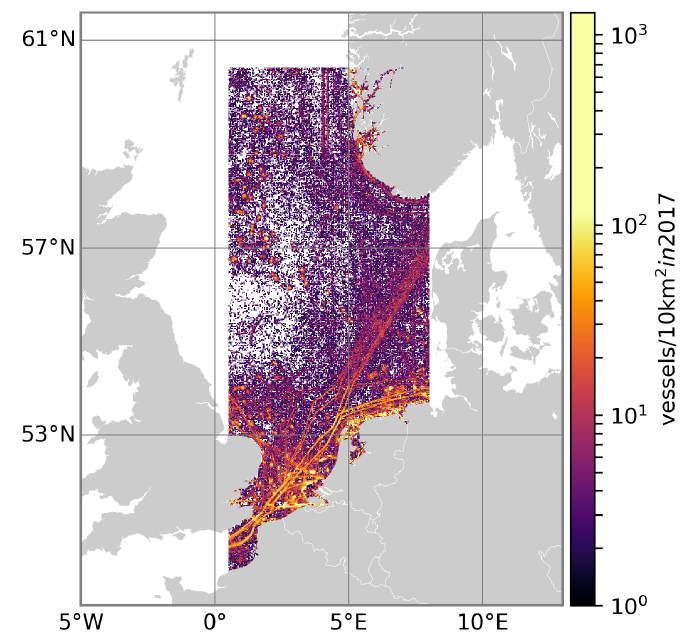
Figure 2. Density map of the 868,237 vessels detected by SUMO in